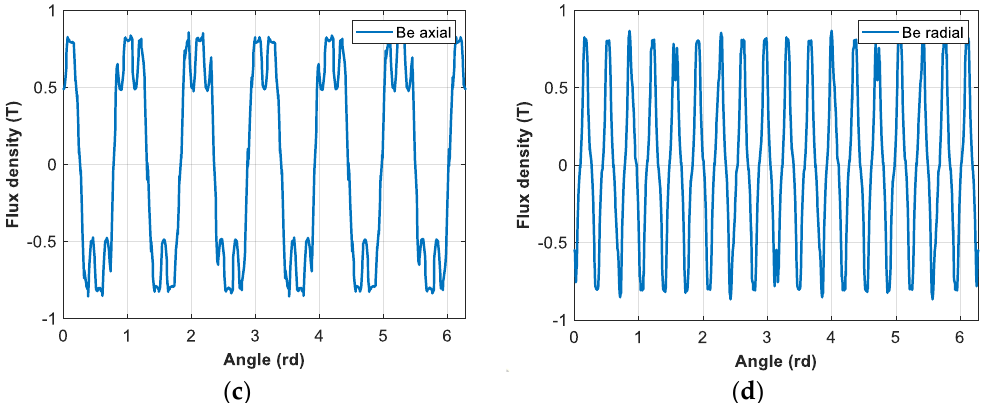
Figure 6. No-load air gap flux density of ( a ) three − phase; ( b ) five − phase; ( c ) seven − phase AFM; ( d ) seven − phase HFM radial air gap.